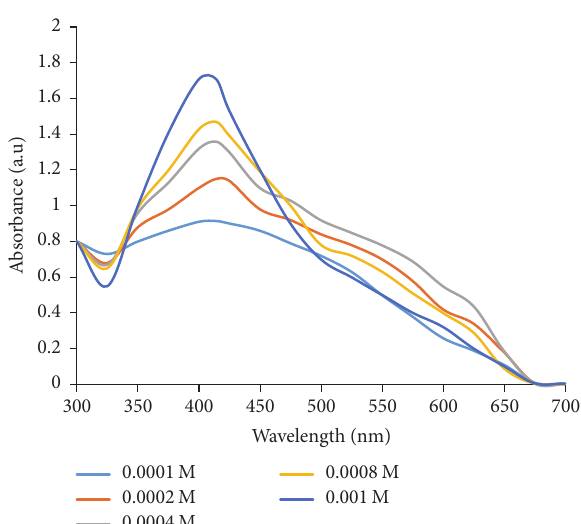
Figure 5: UV-Vis spectra of WMRE-AgNPs showing the effect of variation of AgNO 3 concentration on WMRE-AgNPs synthesis.